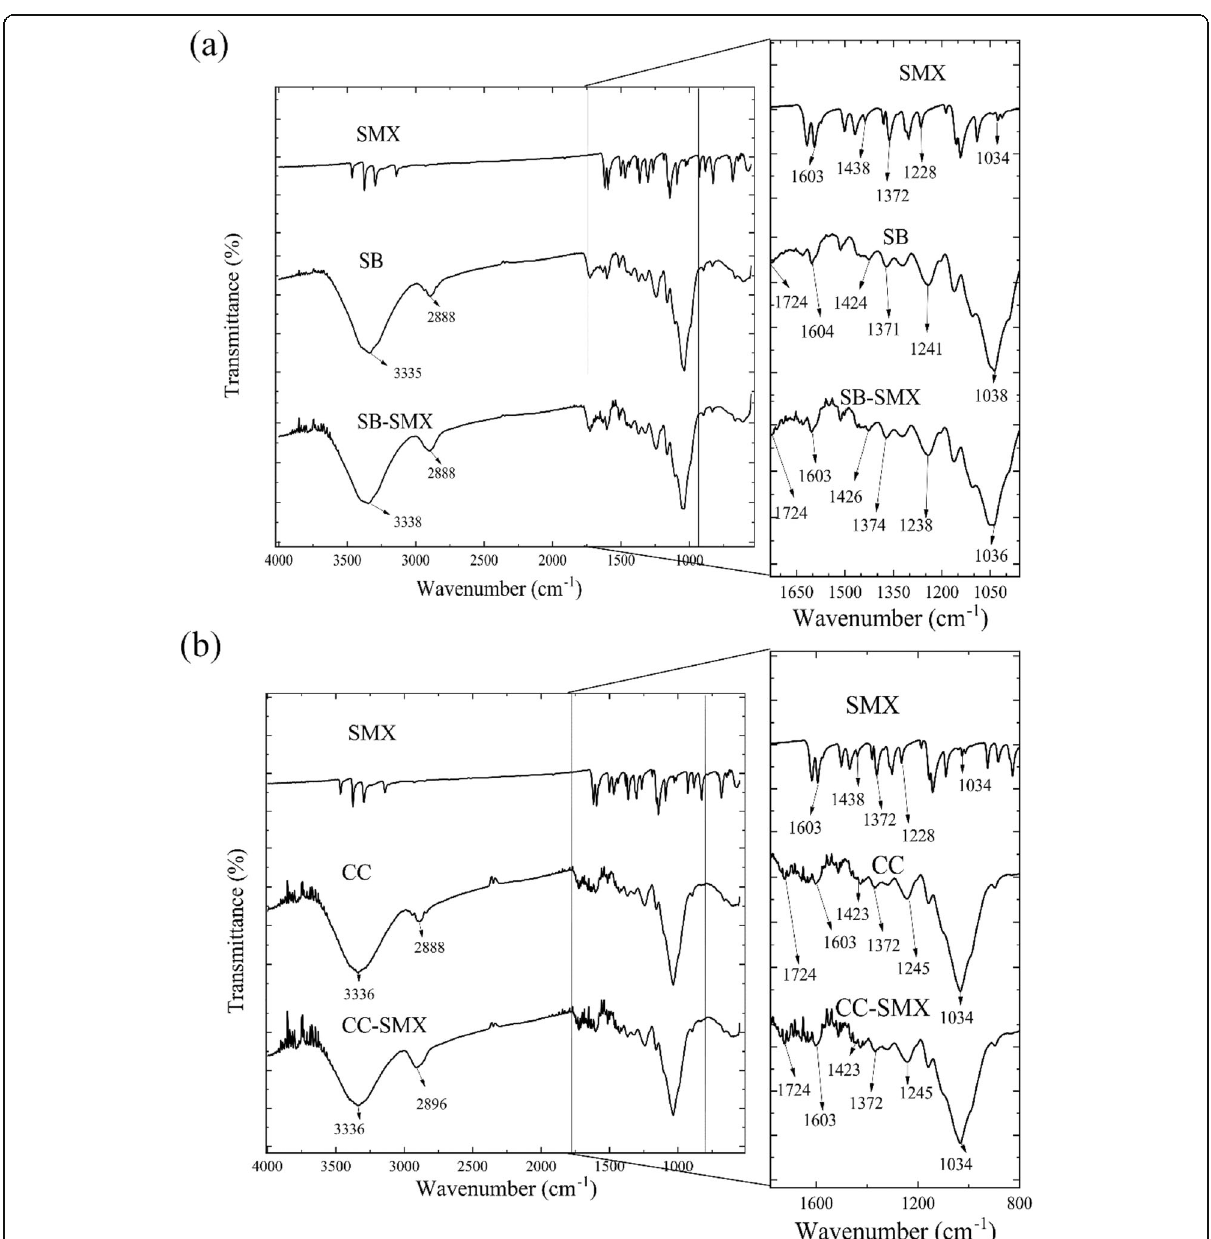
Fig. 2 FTIR spectrum of SB and SB-SMX ( a ), CC and CC-SMX ( b